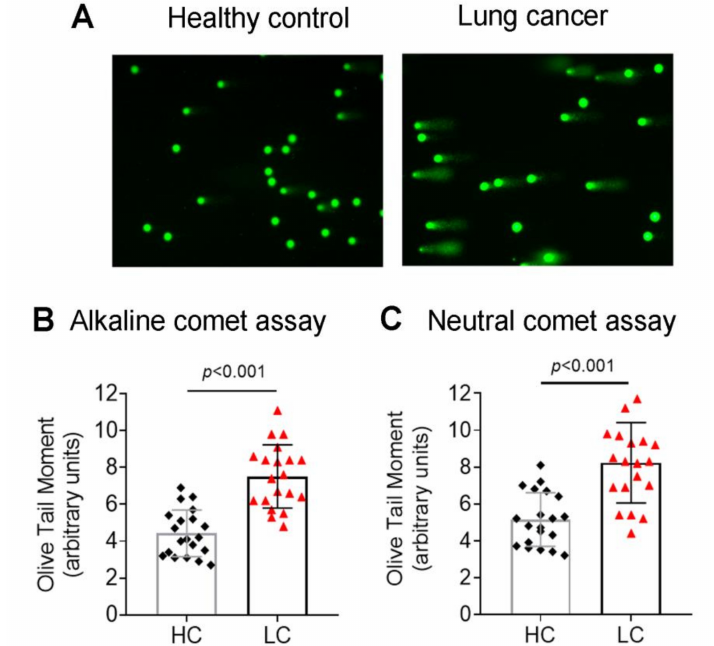
Figure 1. Endogenous DNA damage in lung cancer patients. ( A ) Representative alkaline comet assay images of PBMCs from one healthy control and one lung cancer patient. Box plots showing statistical distribution of the endogenous DNA damage measured by ( B ) alkaline comet assay or ( C ) neutral comet assay. HC, healthy control, black square; LC, lung cancer, red triangle. The experiments shown were based on a minimum of 3 independent